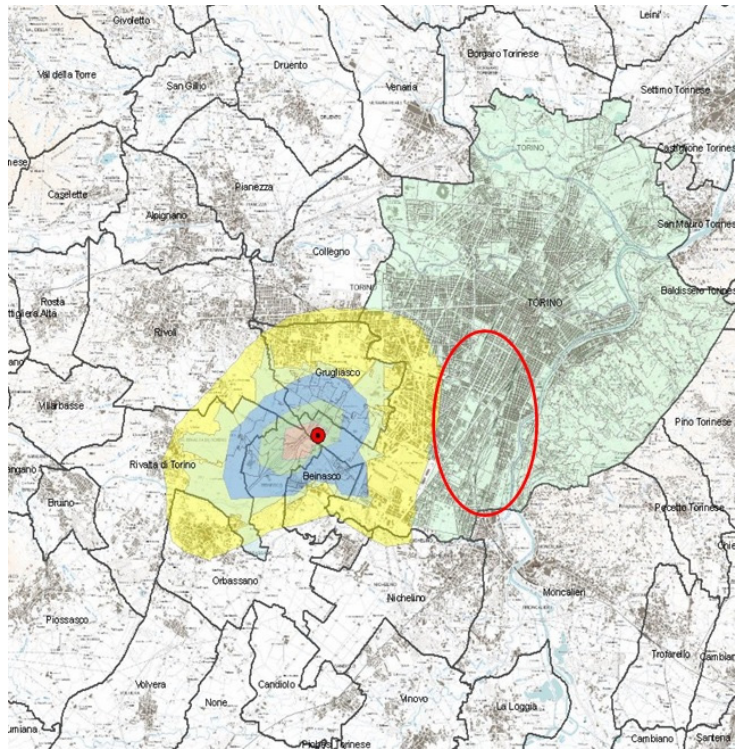
Figure 1. Fall-out map. Red dot is the WTE plant location; green area is the municipality of Turin. Blue area corresponds metals depositions >0.014 mg/m 2 /year (exposed group). Red ellipse corresponds to the area of Turin municipality where control group is sampled (unexposed group).